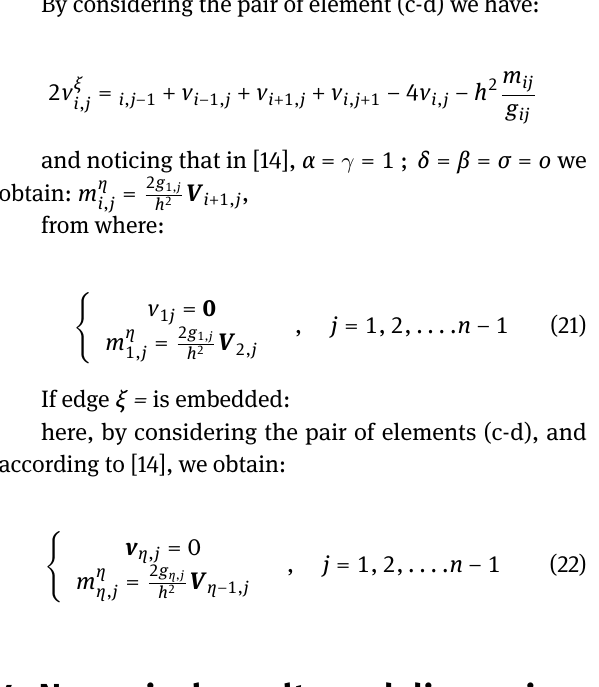
Figure 3: Square plate of variable thickness hinged on all